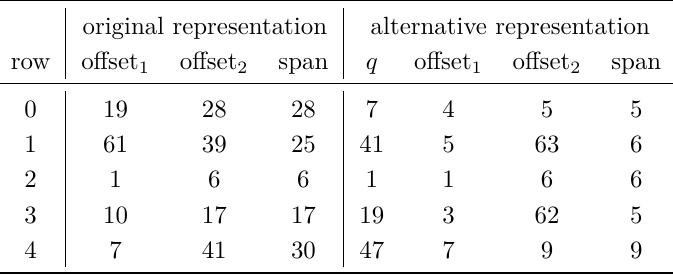
Table 2: List of parameters for the original and alternative representation of the linear diffusion layer of Ascon